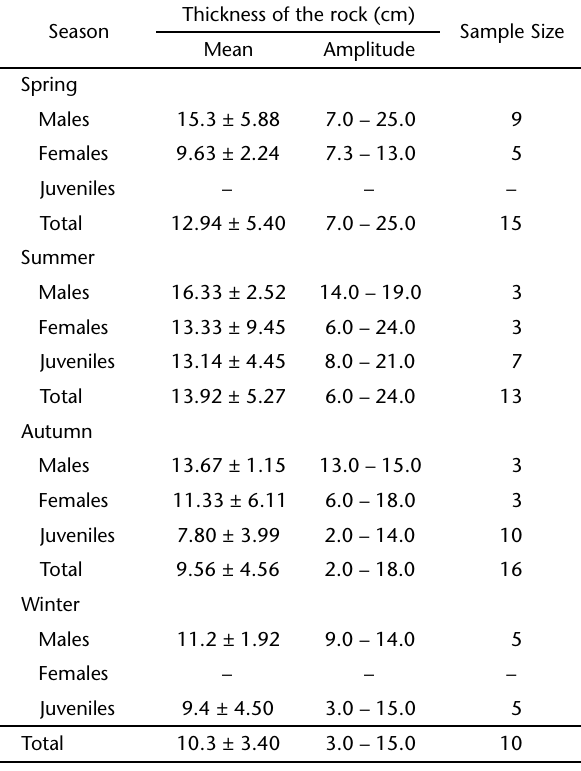
Table I. Thickness of the rocks under which C. vacariensi s constructed their burrows throughout the seasons in the study area, municipality of Bom Jesus, Rio Grande do Sul, between October 2006 and September